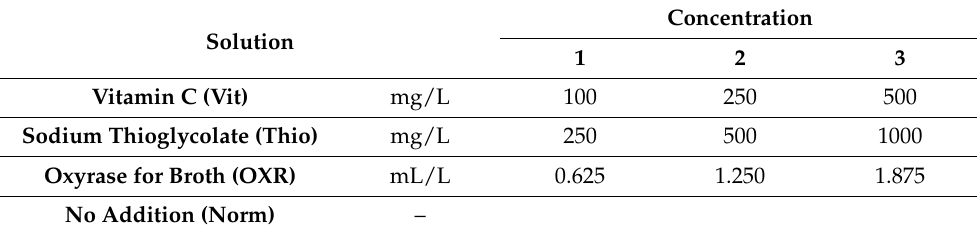
Table 2. Oxygen scavenger variations. Solution